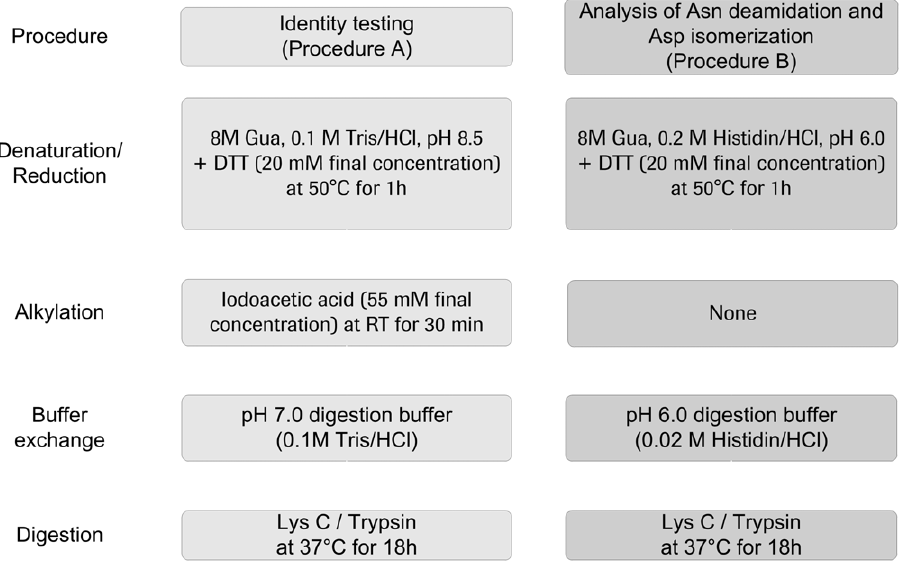
Figure 1. Overview of sample preparation procedures A and B for the UPLC-MS analysis of antibody Asn deamidation and Asp isomerization.